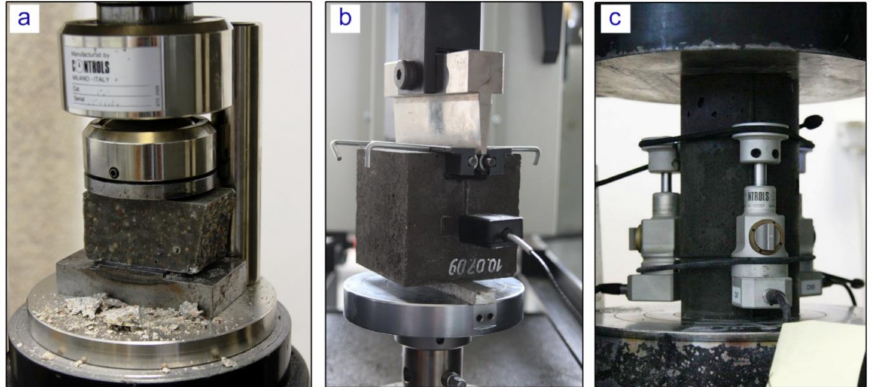
Figure 4. ( a ) Compressive strength test on Controls MCC8 hydraulic press, ( b ) wedge splitting test